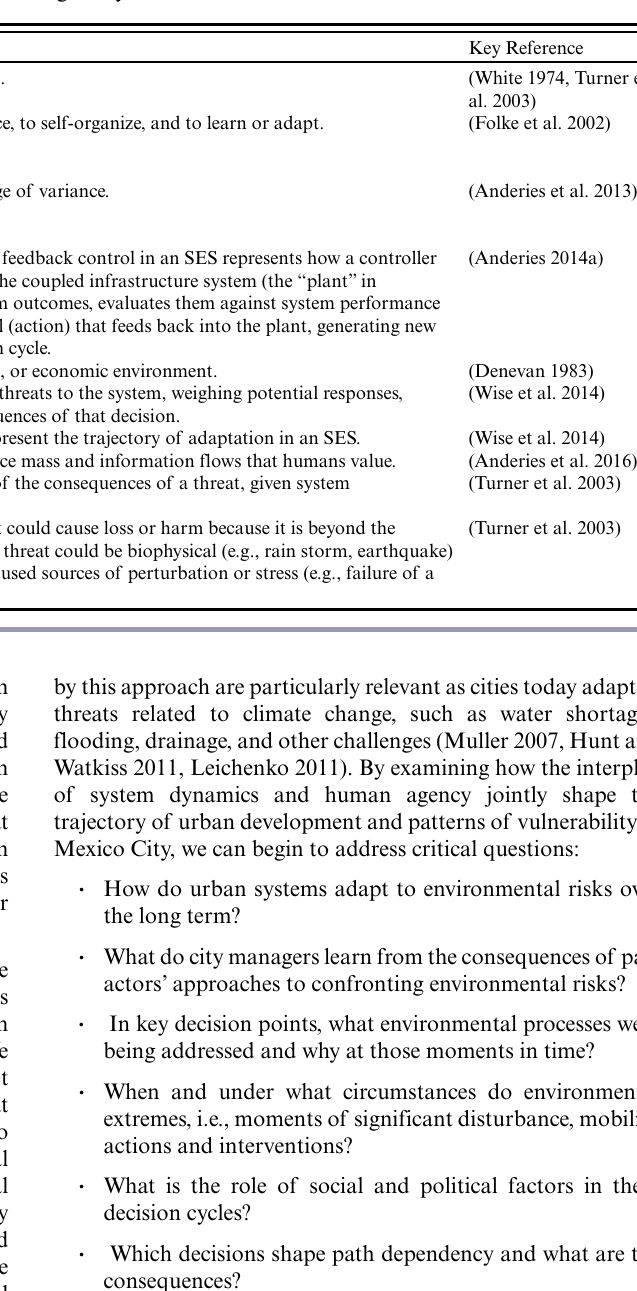
Table 1 . Key concepts, definitions, and references. SES = social-ecological